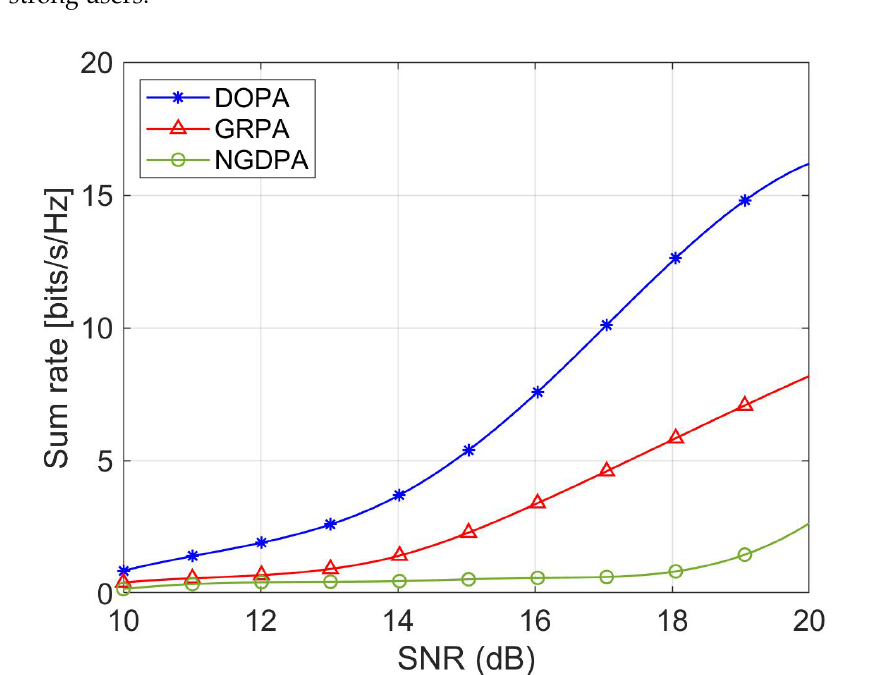
Figure 14. The sum rate of the proposed DOPA against the SNR for α = 1 and K = 10 users, in comparison with the benchmark GRPA and NGDPA